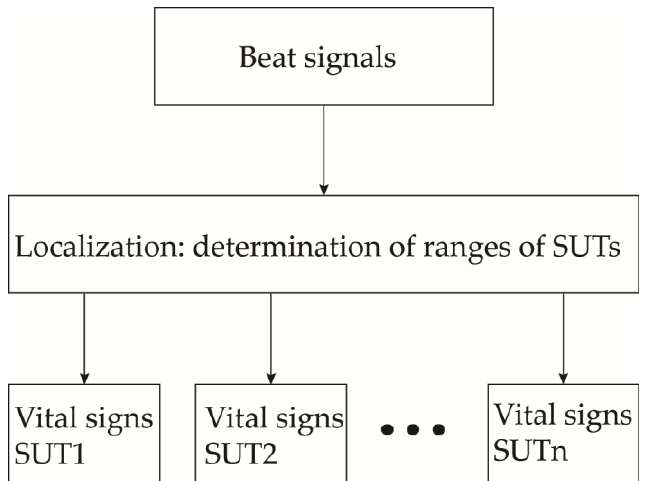
Figure 12. General algorithm used to extract the vital signs of multiple subjects using radar techniques.